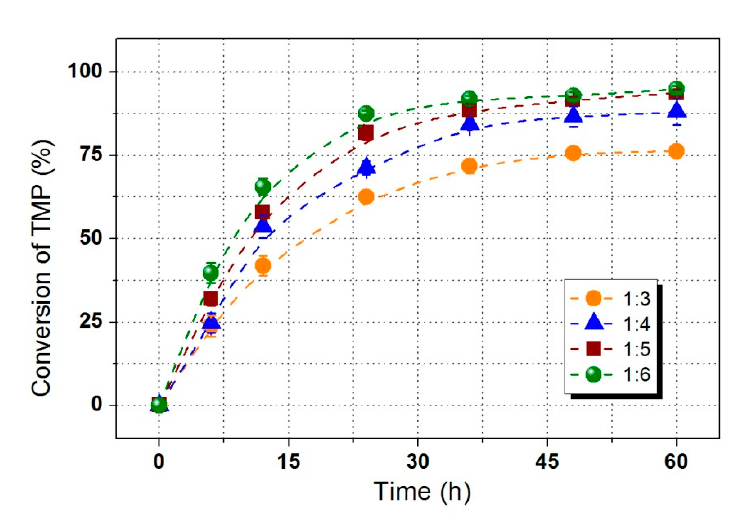
Figure 5. In fl uence of substrates molar ratio on the synthesis of TMP ‐ tri ‐ LA ester.